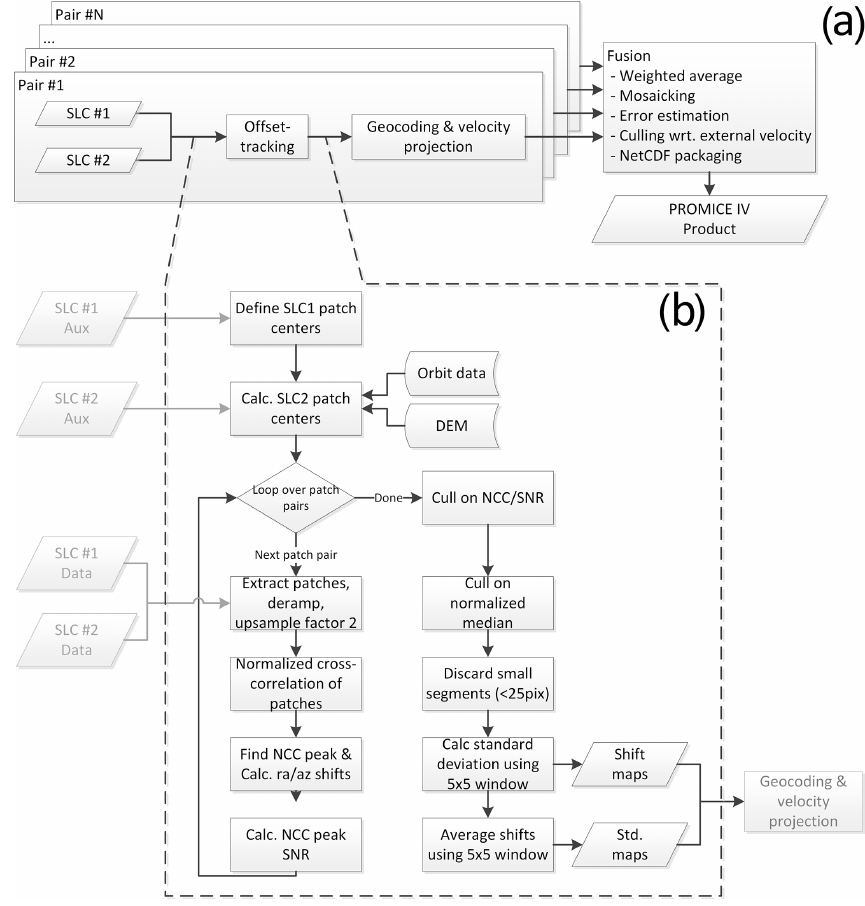
Figure 3. Processing flow for PROMICE Ice Velocity product: (a) high-level processing flow and (b) offset-tracking details.